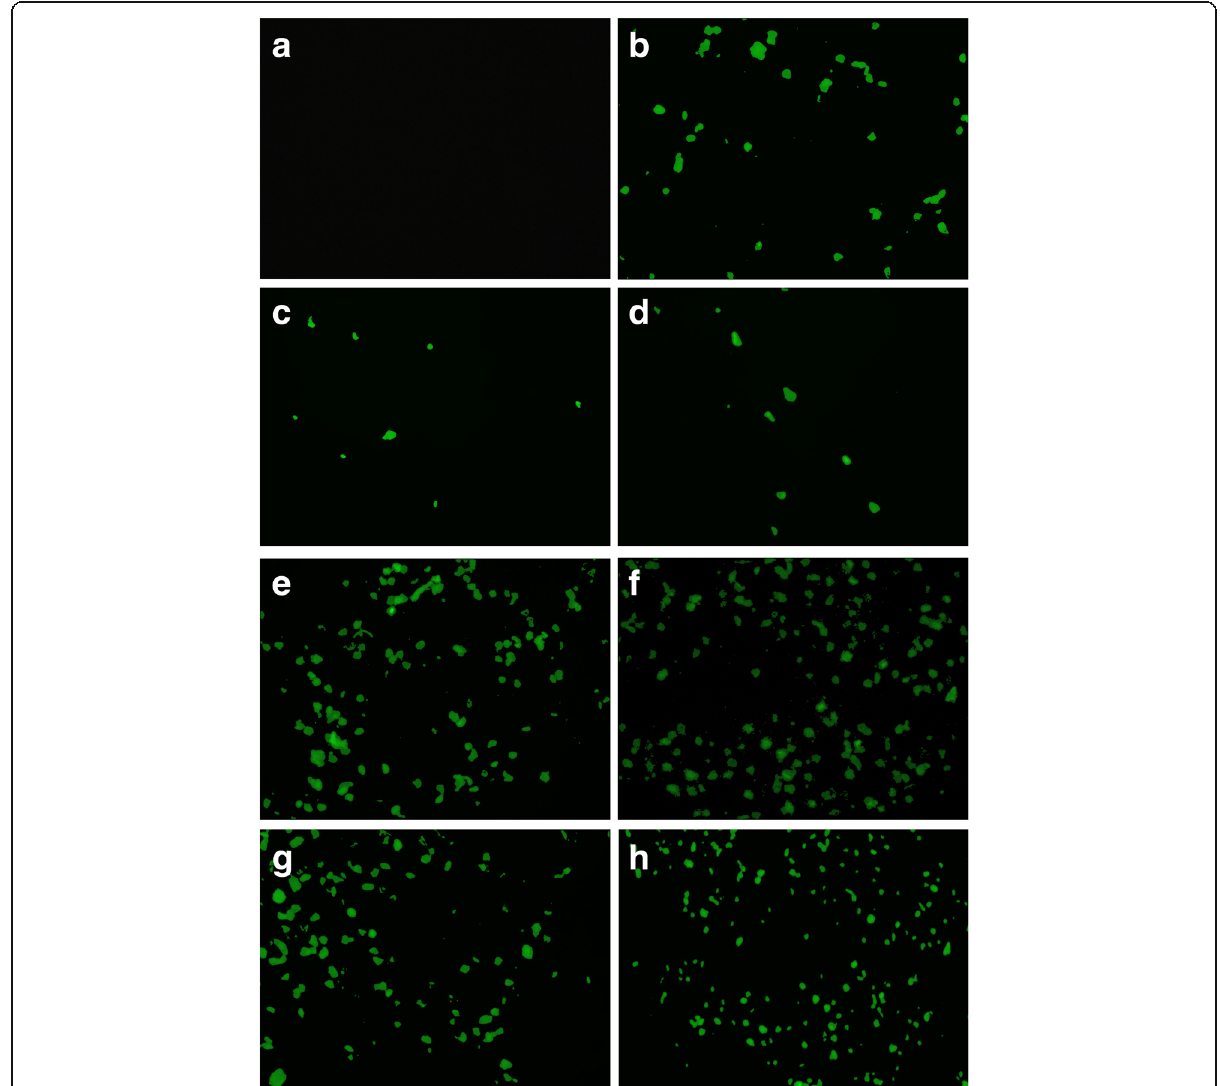
Fig. 9 HEK-293 Homo sapiens (human)-epithelial morphology-embryonic kidney-fetus cell transfection tests (pIRES2-EGFP). a HEK-293 cells, b positive control: LipofectAMINE TM 2000, c CO-AuNP, d Acyl-CO-AuNPs, e COS@1-AuNPs, f COS@2-AuNPs, g COS@3-AuNPs, and h COS@4-AuNPs. Arrows point to transfected